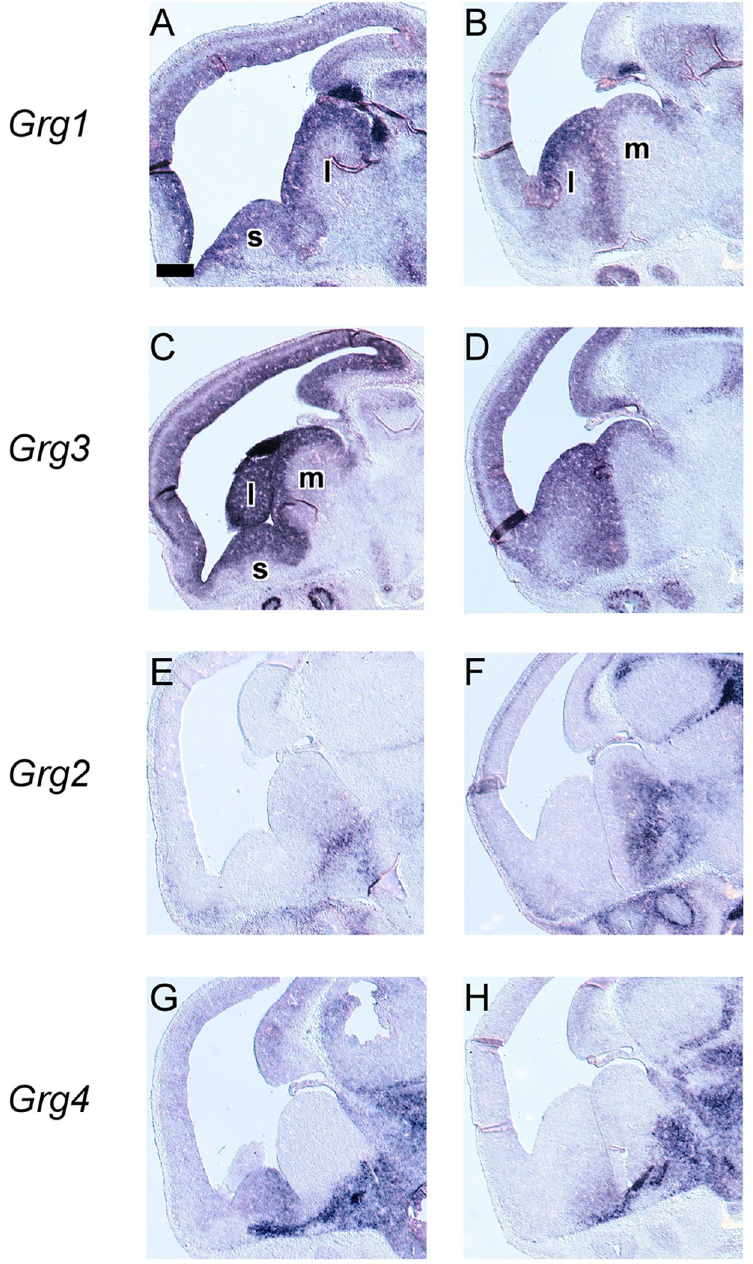
Fig 6. In situ hybridization on adjacent sagittal sections through the embryonic telencephalon from lateral (left) to medial (right) levels hybridized with an antisense RNA probe of Grg1 (A, B), Grg3 (C, D), Grg2 (E,F) and Grg4 (G, H) m: MGE, l: LGE, l: LGE, s: septum. Scale: 200 μ